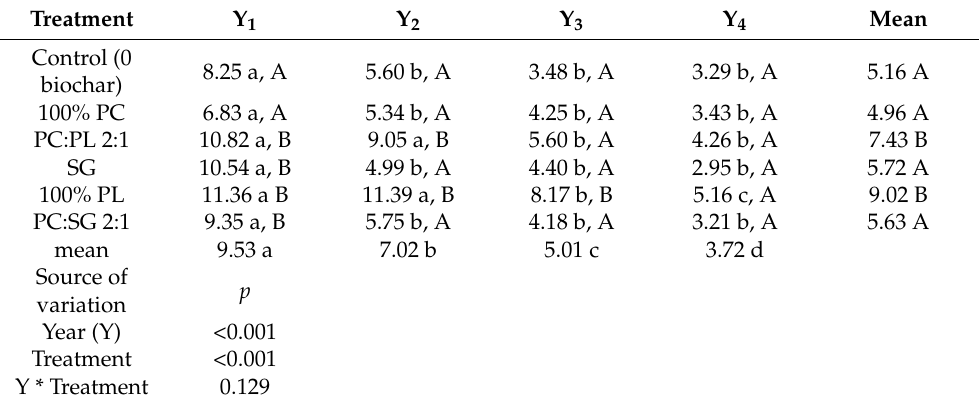
Table 7. Annual corn stover phosphorus (P) uptake (kg ha − 1 ) after treatment with designer biochars (means computed from n = 4; Y = year; PC = pine chip, PL = poultry litter; SG = switchgrass compost). Treatment Y 1